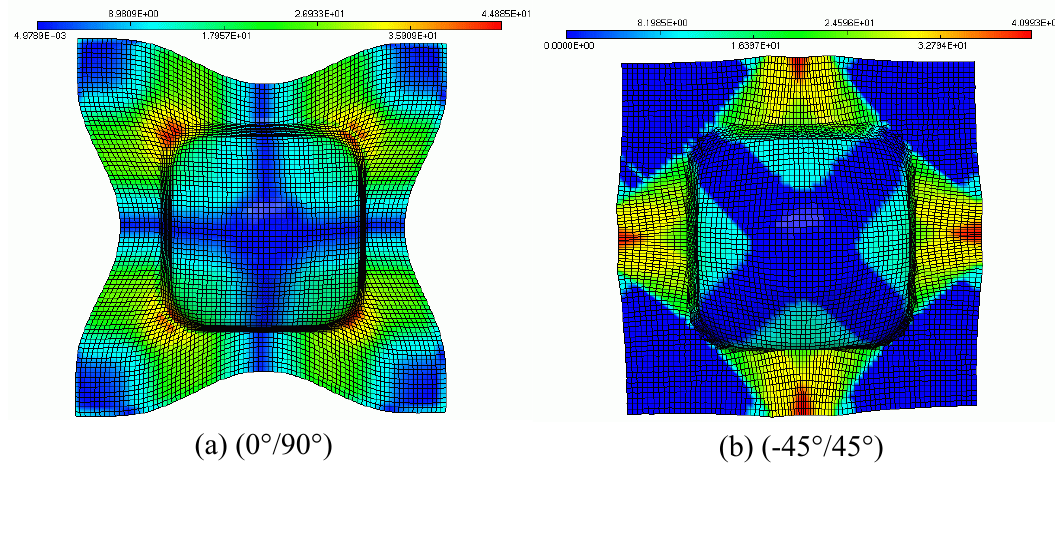
Figure 16. Iso-values of shear between warp and weft